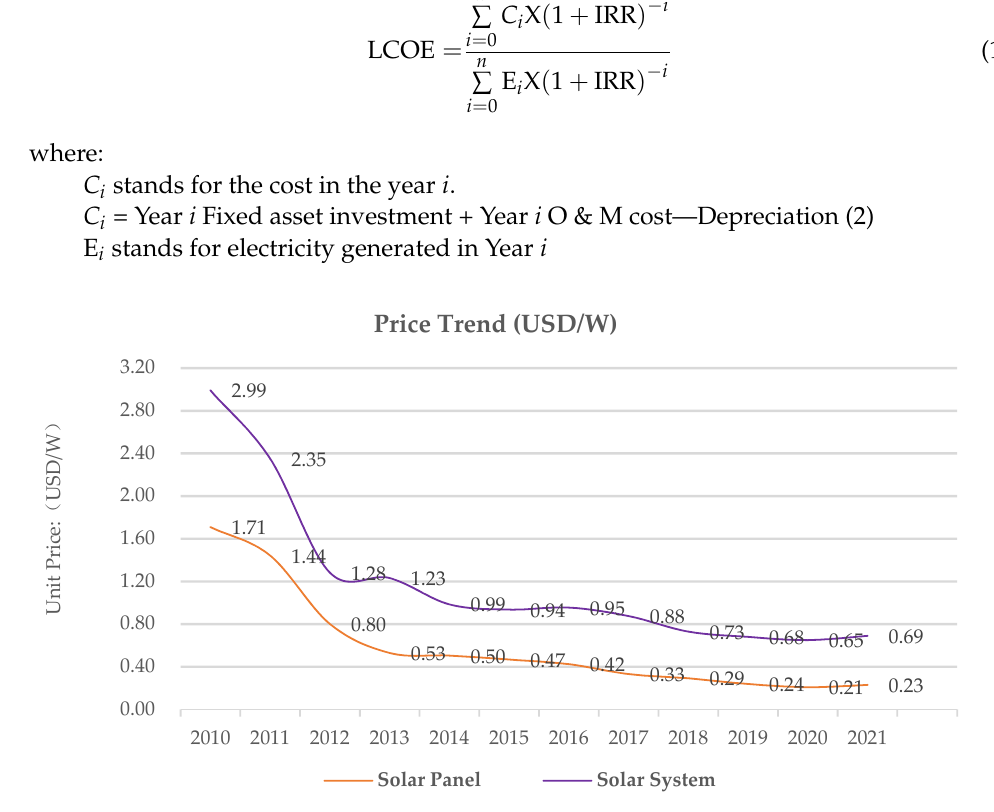
Figure 7. Price trend of solar panels and solar systems. Source: [69].